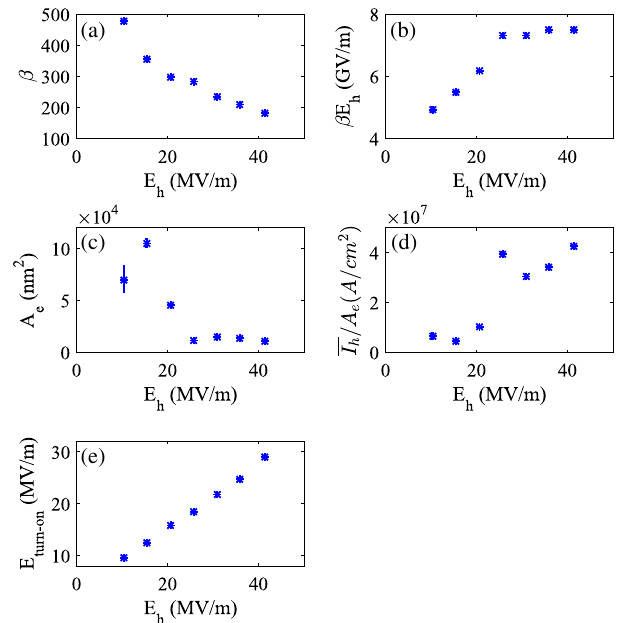
FIG. 14. Evolution of field emission properties during rf conditioning. (a) The field enhancement factor. (b) The maximum microscopic electric field. (c) The effective emission area. (d) The current density. (e) The turn-on field.